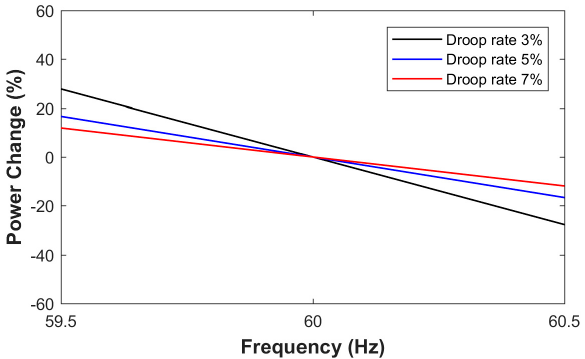
Figure 1. The change of power for different droop rates.